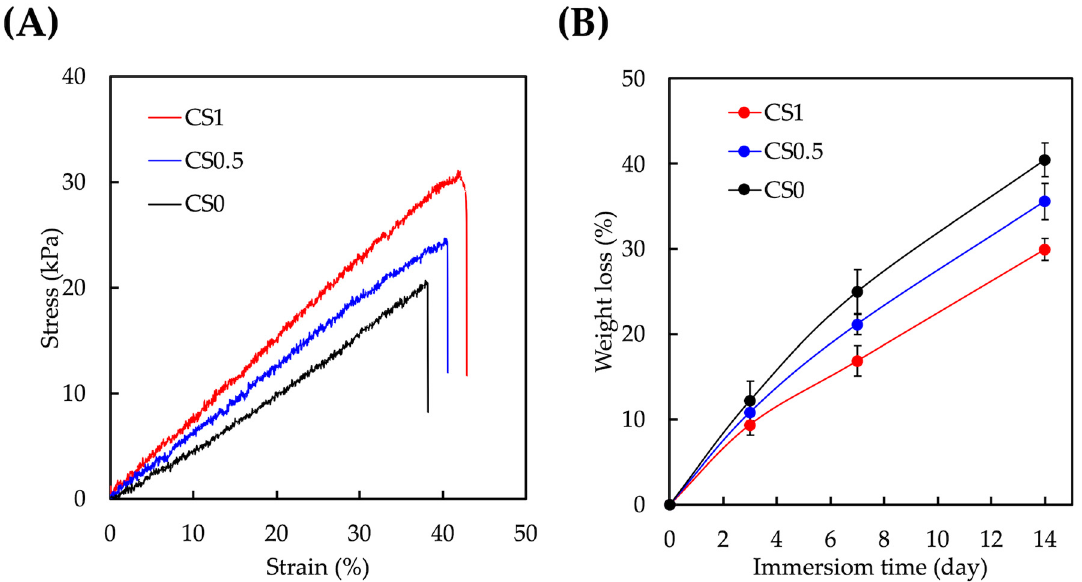
Figure 3. ( A ) Tensile stress–strain curves and ( B ) weight loss profiles of CS0, CS0.5, and CS1. Data presented as mean ± SEM, n = 6 for each group. presented as mean ± SEM, n = 6 for each